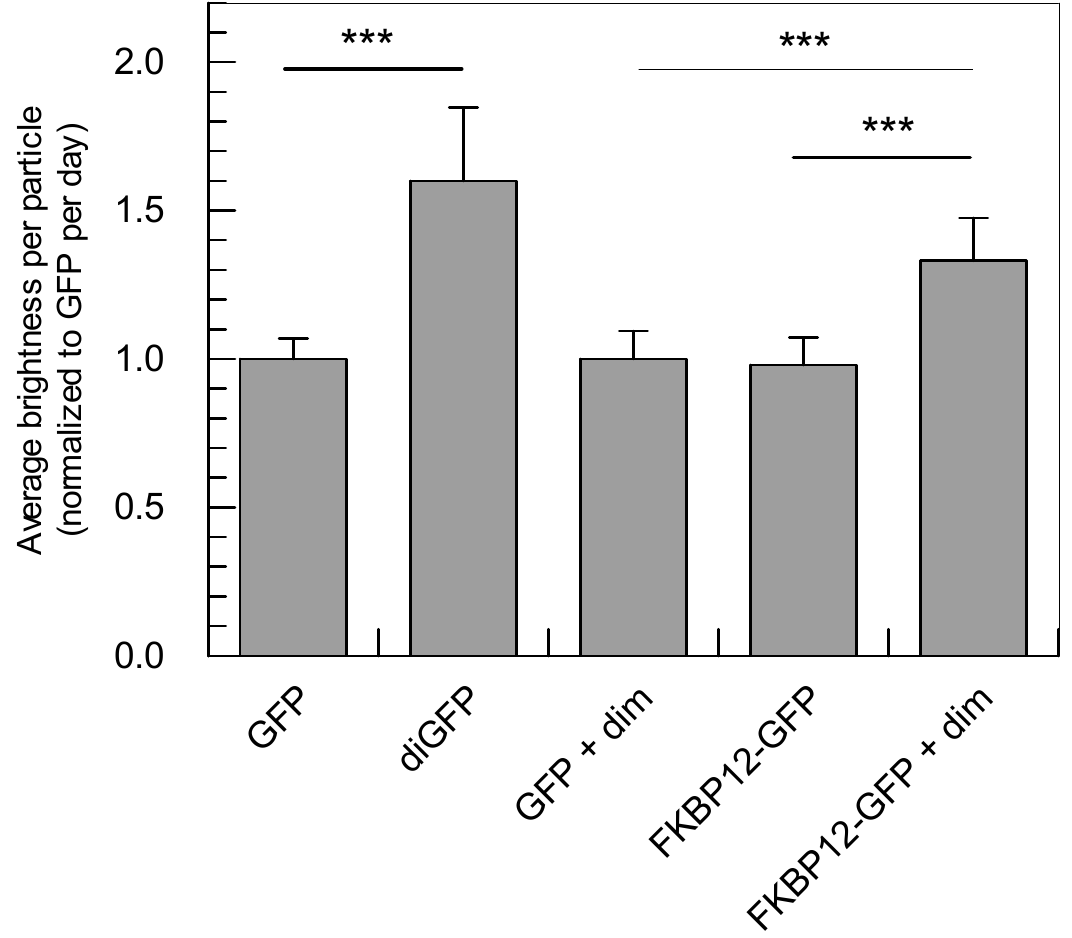
Figure 4. Average brightness calculated from analysis of multiple cells. The apparent brightness of several proteins was measured in living Dictyostelium cells and normalized to GFP per day. Averages were calculated from 24–35 cells per sample from 3 independent measurement days, as in Table 4. Error bars indicate standard deviations. FKBP12-GFP: GFP-linked dimerizing domain; +dim: cells have been incubated with 1 µM dimerizer for 3 h; *** p < 0.001.